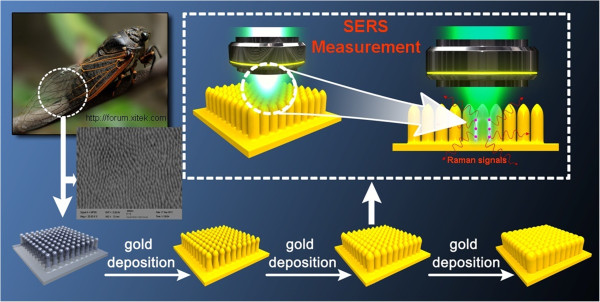
Schematic illustration of the fabrication program of the SERS substrates. The ordered array of nanopillar structures on the cicada wing was used directly as the template. The SEM image and schematic illustration of the nanopillar structures are shown. The Au films were deposited on the cicada wings to engineer the nanostructures and define the gap size.